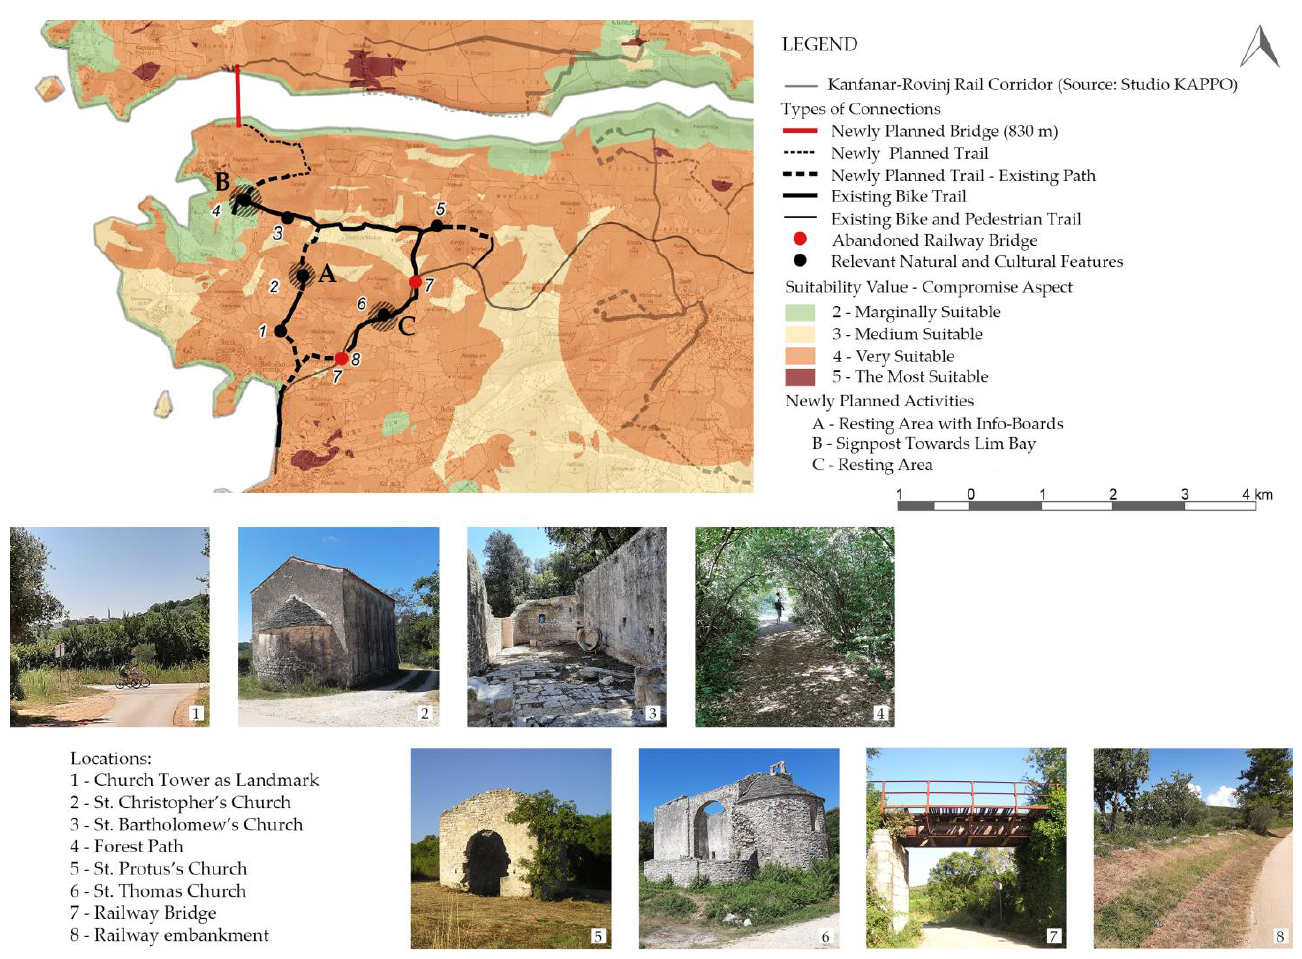
Figure 10. The Rovinj functional area.